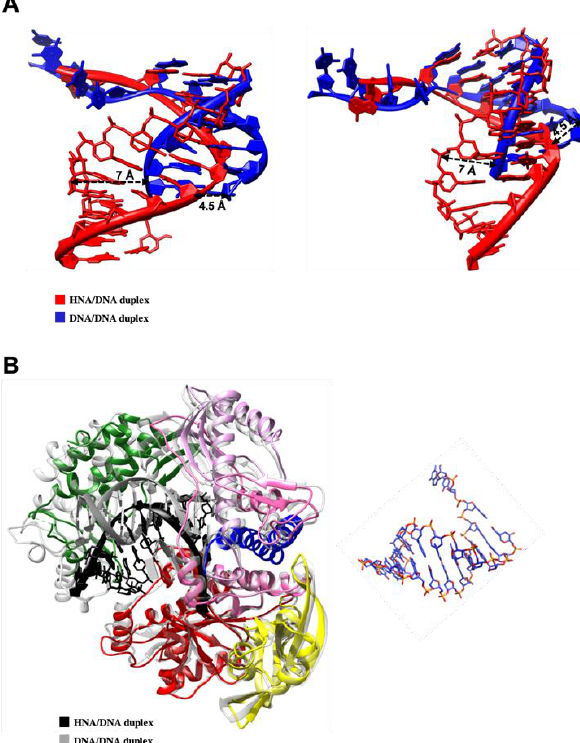
Figure 5. Comparison between a natural DNA-DNA duplex and a HNA-DNA duplex bound to Tgo_6G12. ( A ) Overlay of the HNA-DNA primer-template duplex (in red) with the natural DNA-DNA duplex (in blue), in two different orientations (left and right panels). Deviation between the two duplexes is labeled with dash lines. ( B ) On the left, superimposition of our X-ray ternary structure solved with a DNA/DNA duplex (colored by domains) with the in silico ternary structure modeled and equilibrated in the presence of an HNA/DNA duplex (in light grey). The DNA/DNA duplex is labeled in grey whereas the HNA/DNA duplex is labeled in black. On the right is represented the HNA/DNA duplex as stick, at the same scale.